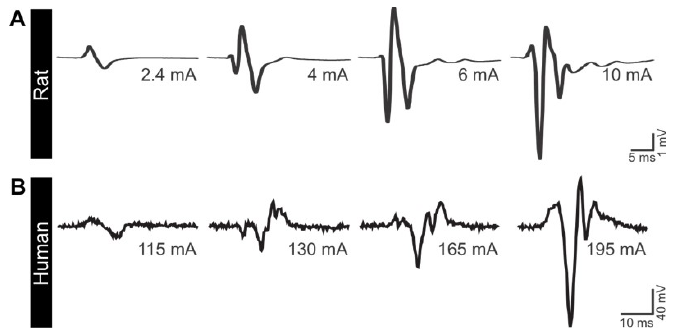
Figure 3. tSCS can activate complex spinal circuitry at higher intensity. As the stimulation intensity is augmented, tSCS-evoked TEPs recorded in TA display an increased number of peaks in rats ( A ) and humans ( B ).